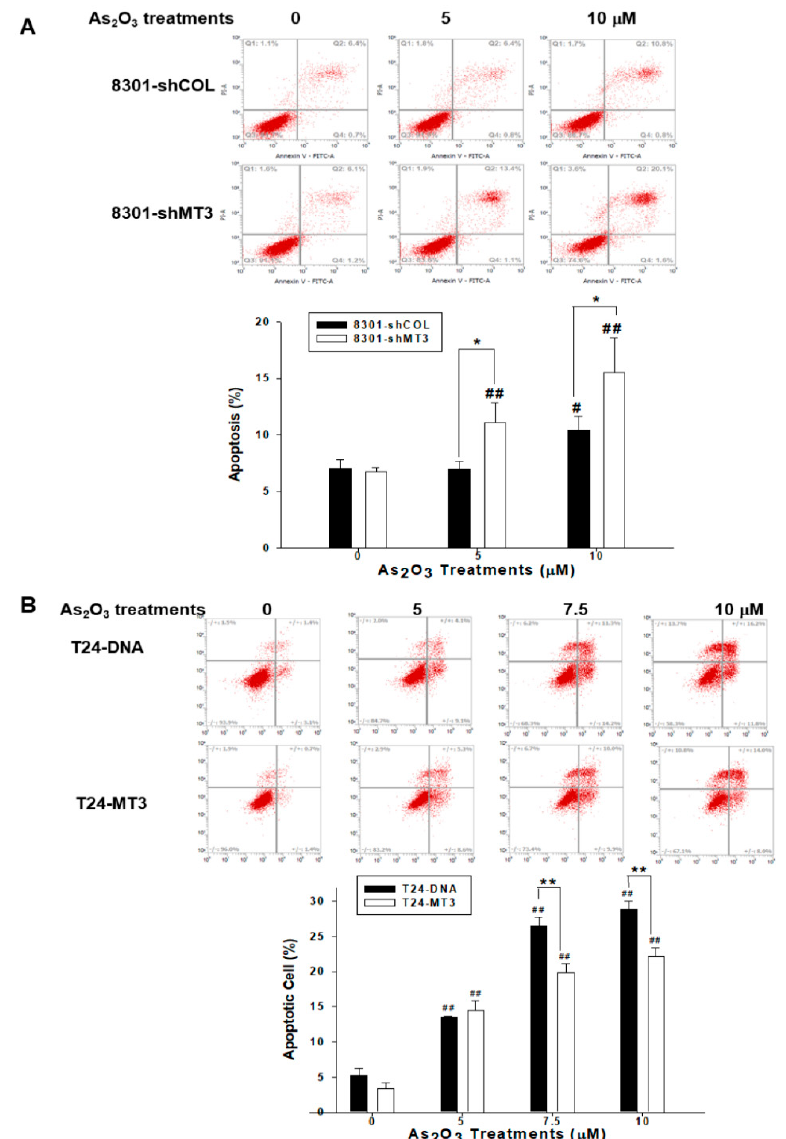
Figure 5. Modulation of MT3 on As 2 O 3 -induced cell apoptosis in bladder carcinoma cells. ( A ) TSGH-8301 (8301-shCOL and 8301-shMT3) and ( B ) T24 (T24 − DNA and T24 − MT3) cells after treatments with different concentrations of As 2 O 3 for 24 h. The fluorescence intensity for Annexin V-FITC in conjunction with PI staining to distinguish among early apoptotic, late apoptotic, and necrotic cells was determined by using flow cytometry. Data are presented as the percentage of apoptotic cells after treatments (* and # p < 0.05, ** and ## p < 0.01).